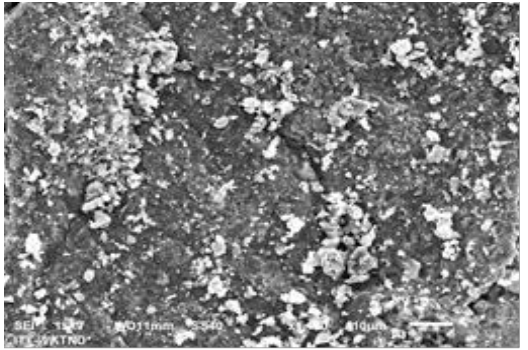
Figure 1. SEM image of Fe material.